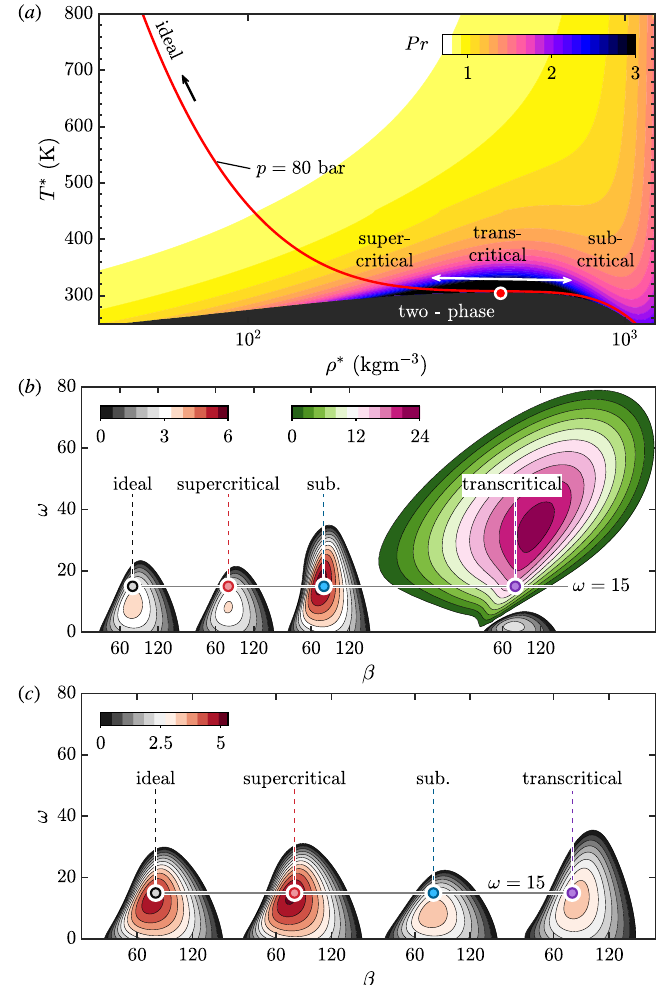
Figure 2. ( a ) Temperature–density diagram of CO2 colored by the Prandtl number. The solid red line corresponds to the isobar of 80, near which a three-dimensional boundary layer is considered. The red dot marks the critical point close to the Widom line; the ideal, supercritical, transcritical, and subcritical regimes can be seen. ( b , c ) Stability diagrams for different regimes with ( b ) wall cooling and ( c ) heating in the β − ω frame. In panel ( b ), we have used a separate color map for the inviscid Tollmien–Schlichting mode (outmost right), whose growth rate is significantly larger. The colored dots point to modal instability with β = 80 and ω = 15 discussed in Fig.